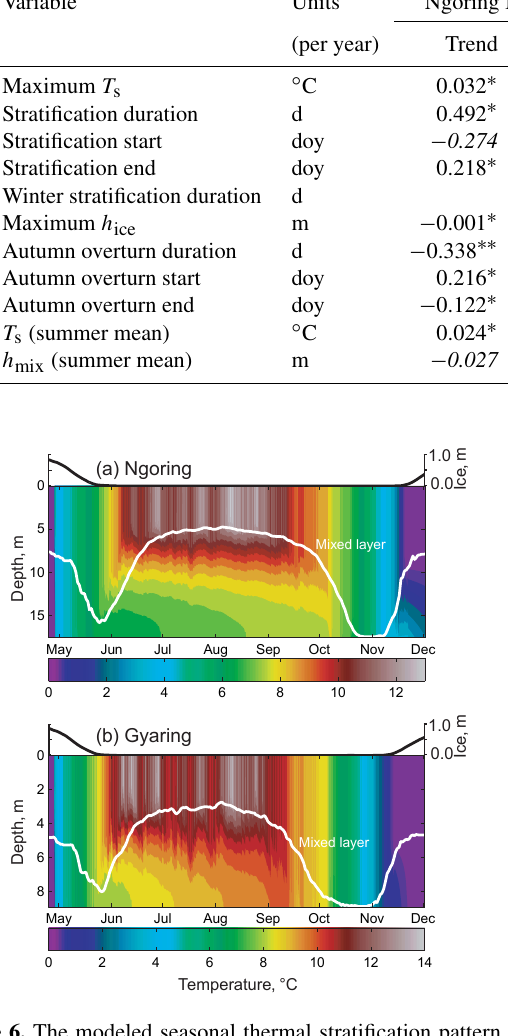
Figure 6. The modeled seasonal thermal stratification pattern and ice cover development in (a) Ngoring and (b) Gyaring. The model was forced by the ERA-Interim reanalysis. Only the values from May to December 1979 are shown. The black line is the ice cover thickness. The white line is the bottom of the surface mixed layer defined as the depth of the maximum vertical temperature gradient.